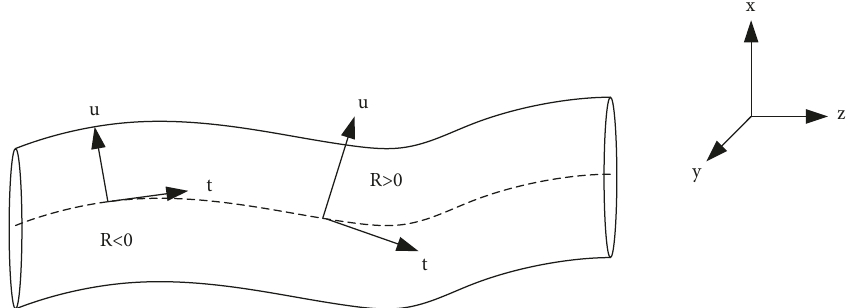
Figure 4: Establishment of orthogonal coordinate system of axisymmetric